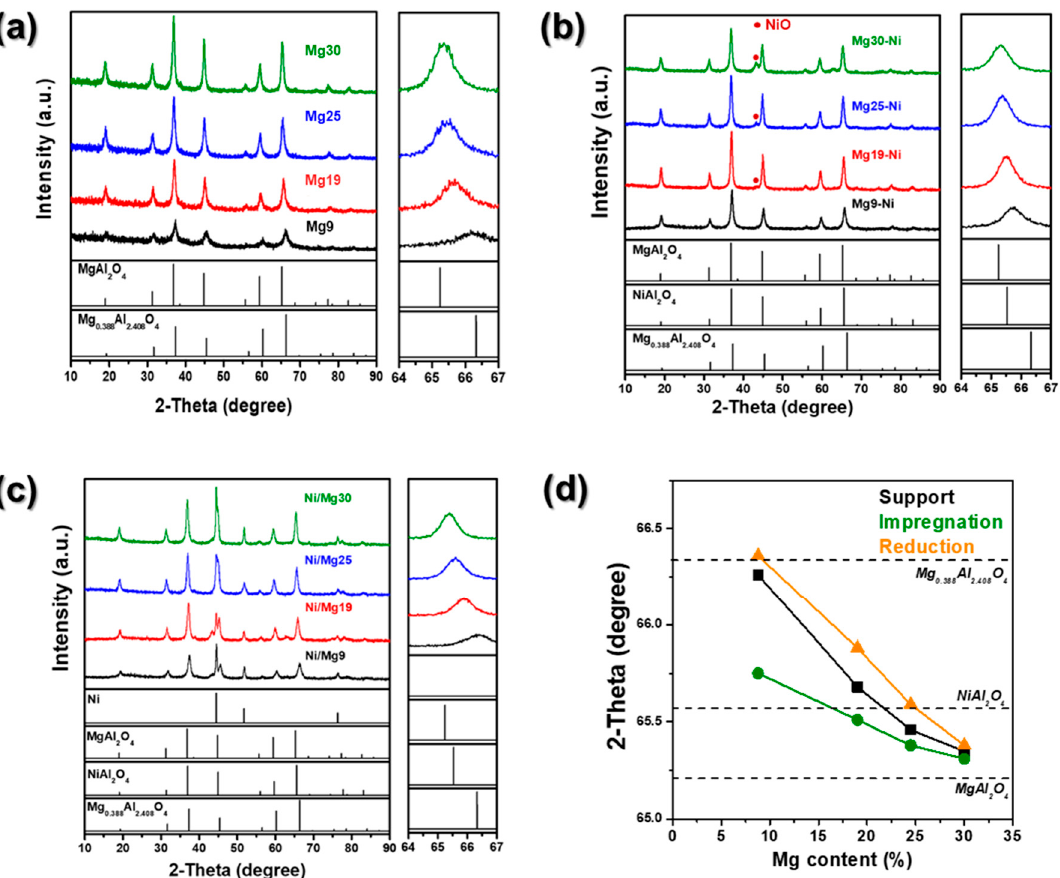
Figure 3. XRD analysis: ( a ) Mg-aluminate support, ( b ) after Ni loading with calcination, ( c ) after reduction, and ( d ) plots of 2-theta shift for (440) plane. Table 1. ICP-AES analysis and the Ni particle sizes evaluated by XRD and TEM.